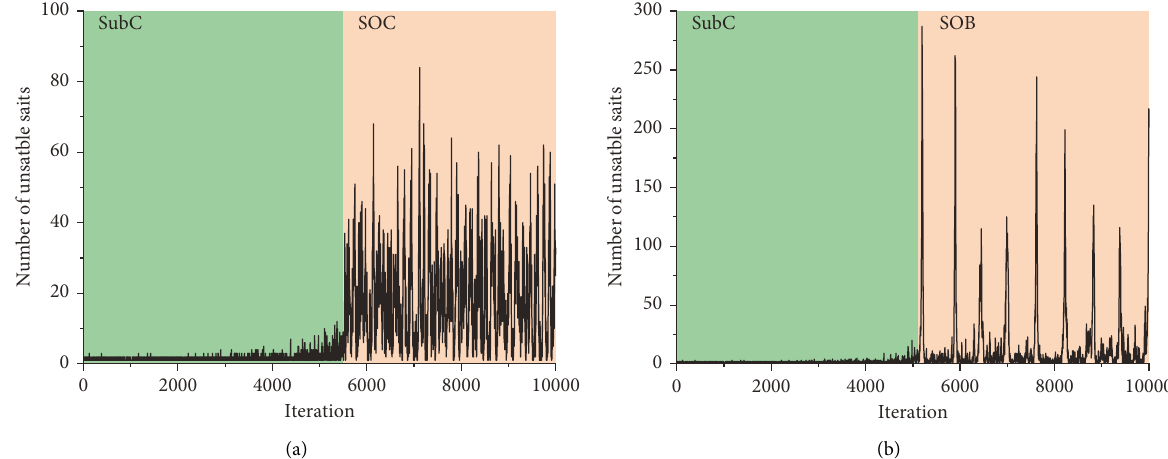
Figure 1: Time series of the number of unstable sites of sand-cell automata. (a) Standard rules of the Manna model and (b) facilitated rules of the Manna model. Table 1: Subcritical time ( t ) and the maximum number of unstable sites ( A Sub C Number of